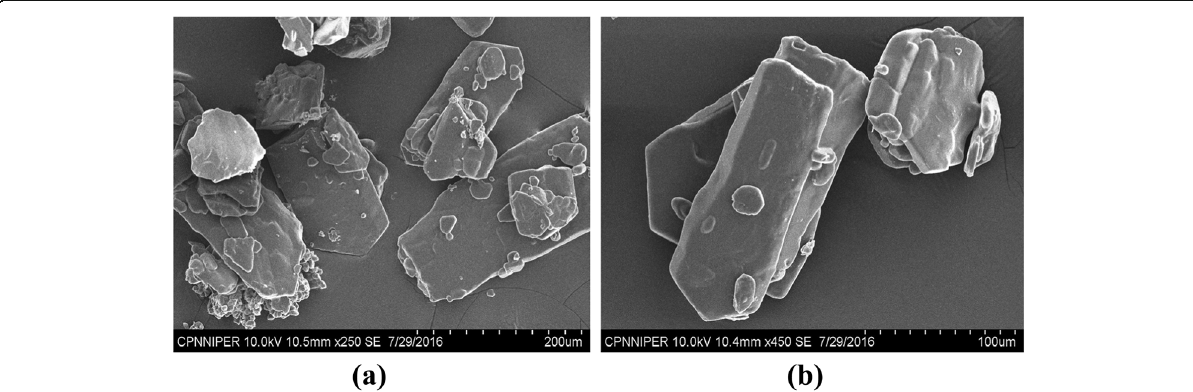
Fig. 7 a Observation by SEM of the EPS from L. paraplantarum KM1. b At higher magnification, additional details of microstructure of EPS were visible